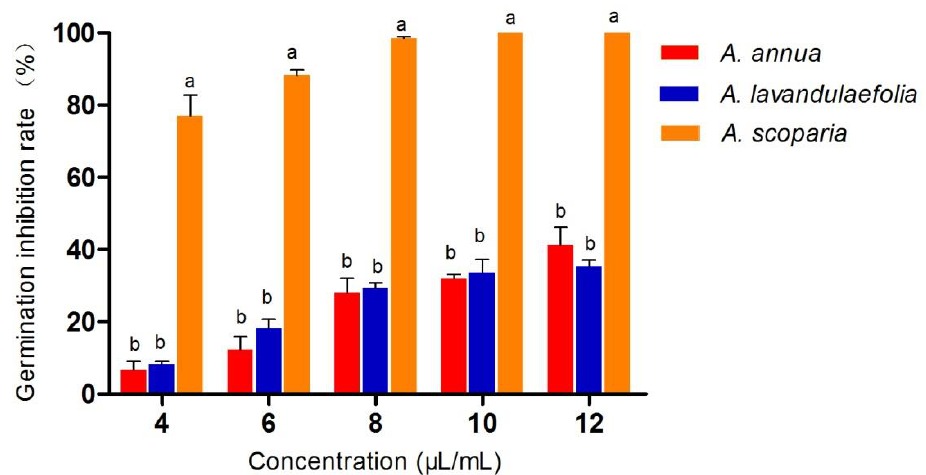
Figure 1. Effects of essential oils spore germination of C. gloeosprioides values, followed by the same letters (a, b) are not significantly different at 5%.